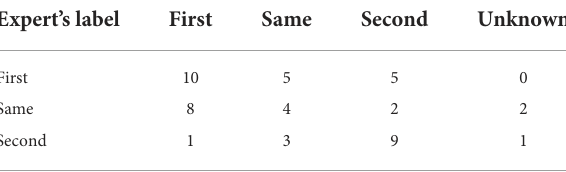
TABLE 3 Confusion matrix between a human expert’s labels and aggregated crowdsourcing labels. Expert’s